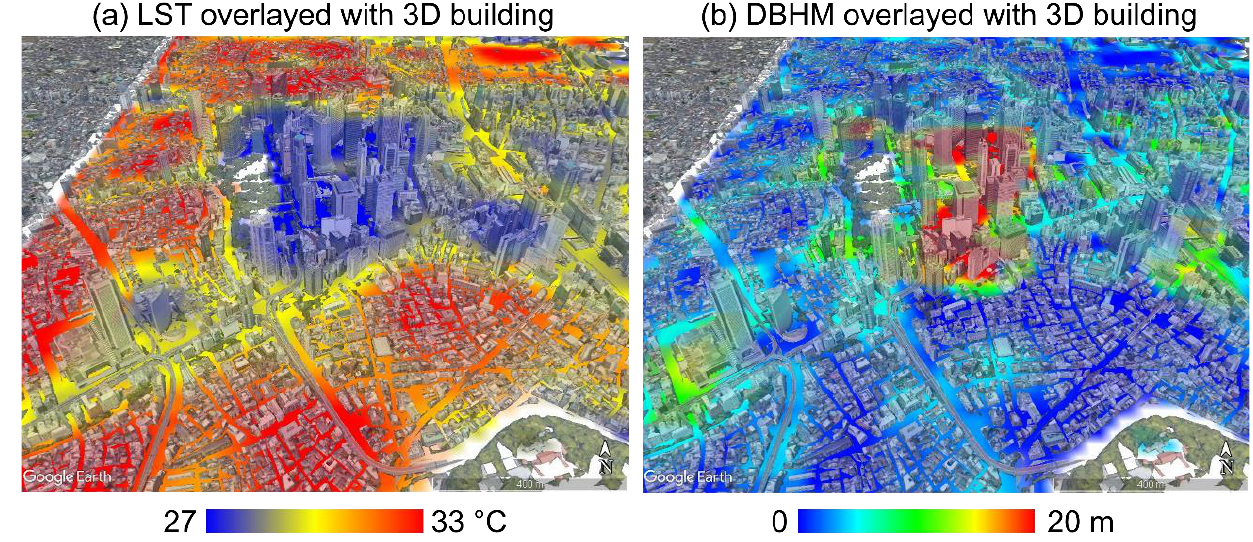
Figure 10. Overlayed averaged ( a ) LST map and ( b ) DBHM map on the 3D building model of Shinjuku, Tokyo (Google Earth, Gray Buildings © 2022